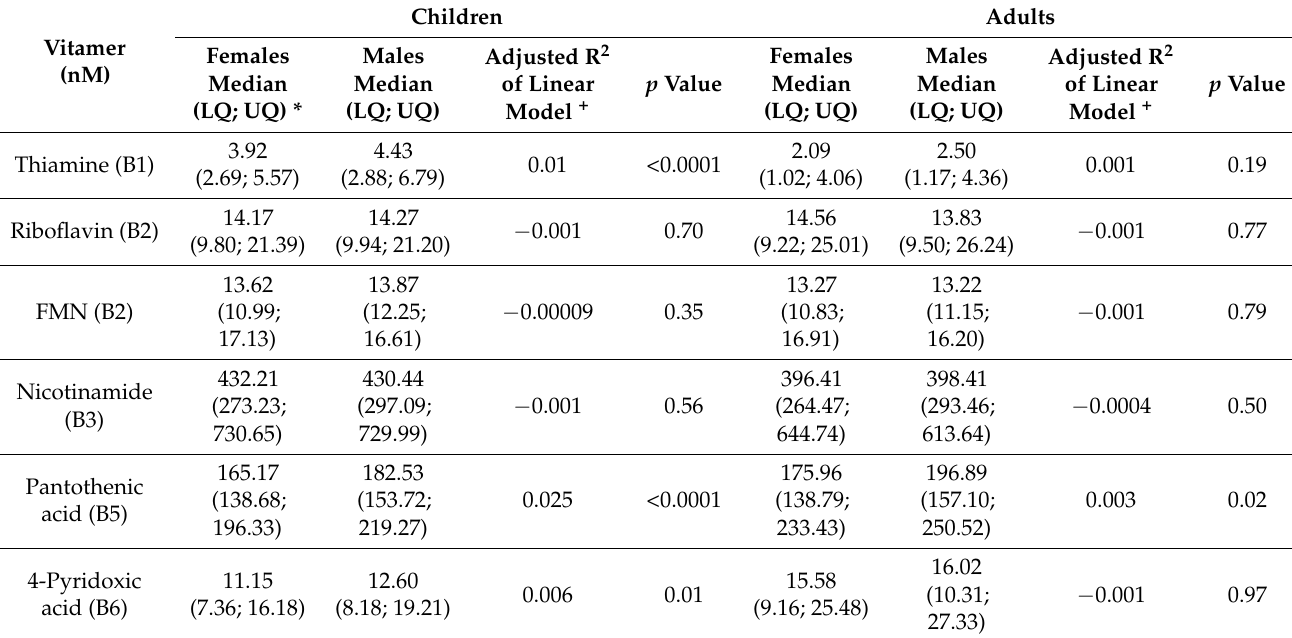
Table 4. Medians, lower/upper quartiles and linear model results of B vitamer levels by sex in each generation.